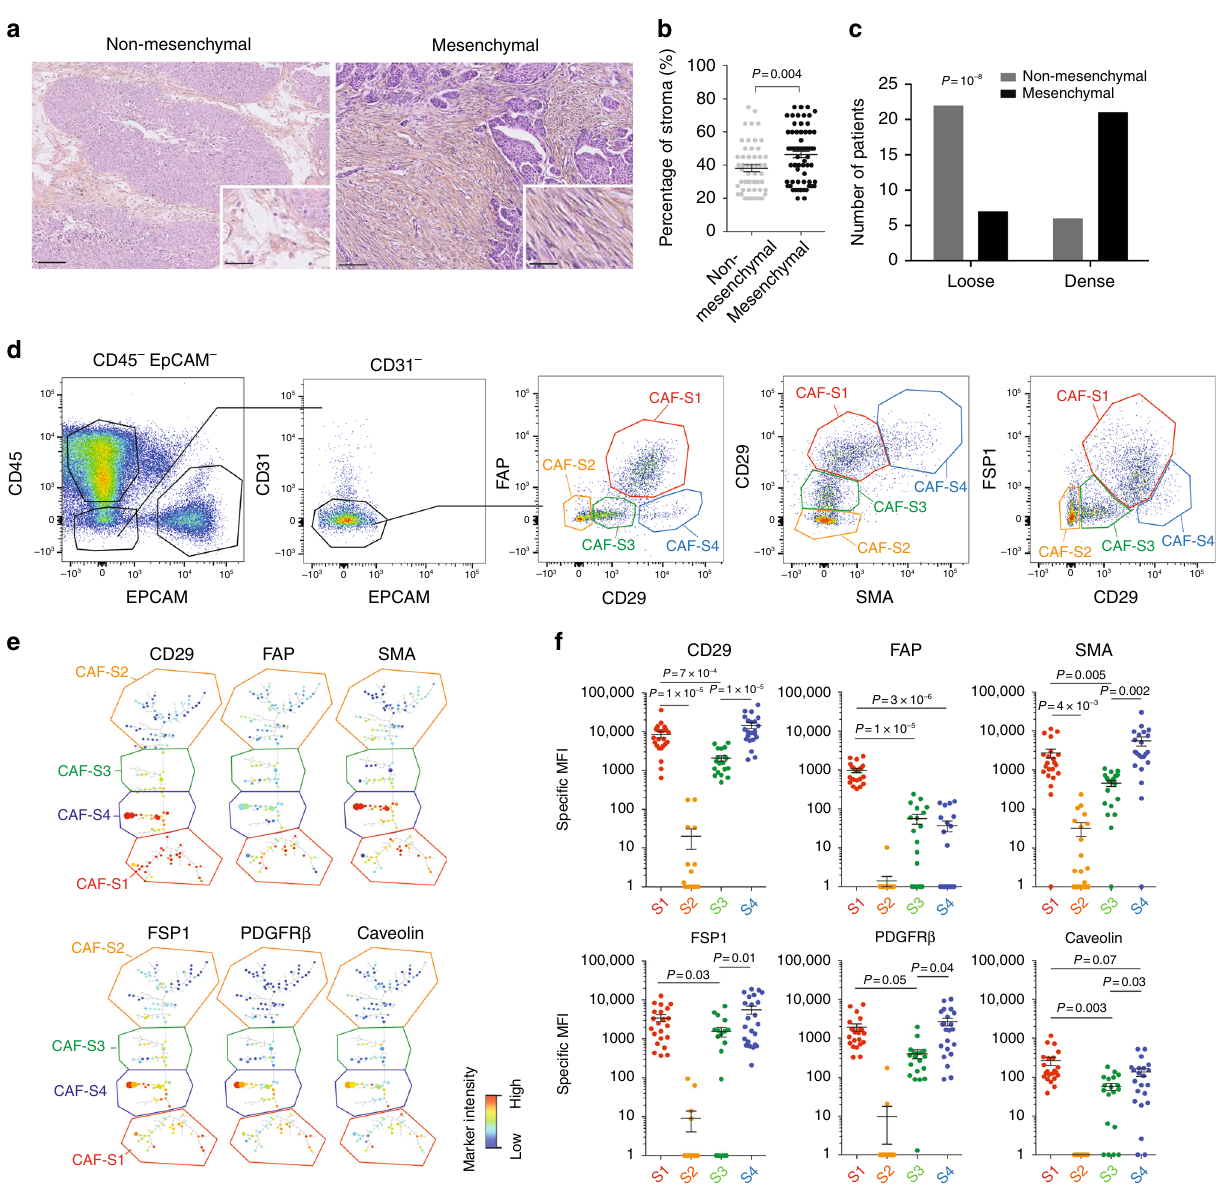
Fig. 1 Identi fi cation of four CAF subsets in HGSOC. a Representative view of HES staining of non-mesenchymal and mesenchymal HGSOC sections (Institut Curie cohort). Scale bar, 100 μ m (low magni fi cation) and 40 μ m (inset). b Scatter plot showing the percentage of stroma in HGSOC. N = 107. Data are shown as mean ± SEM. P values are from Mann-Whitney test. c Bar plot showing association of mesenchymal HGSOC with stromal features, de fi ned by pathologists as loose (low stromal cellularity) or dense (high stromal cellularity). N = 56. P value is from Fisher ’ s Exact Test. d Gating strategy to identify CAF subsets in HGSOC by FACS. Results from a representative HGSOC patient are shown. Cells isolated from freshly dissociated human HGSOC were fi rst gated on DAPI − , EPCAM − , CD45 − , CD31 − cells, for excluding dead cells (DAPI + ), epithelial cells (EPCAM + ), hematopoietic cells (CD45 + ), and endothelial cells (CD31 + ). Selected cells were next examined using six fi broblast markers. Representative fl ow cytometry plots show gating strategies based on FAP, CD29, SMA, and FSP1 that allow the identi fi cation of four sub-populations of fi broblasts in HGSOC: CAF-S1 are CD29 Med FAP High SMA High FSP1 High , CAF-S4 are CD29 High FAP Low SMA High FSP1 Med , CAF-S3 are CD29 Low FAP Low SMA Low FSP1 Med/High and CAF-S2 are CD29 Low FAP Low SMA Low FSP1 Low . e CytoSpade trees annotated with each marker expression in HGSOC analyzed by FACS. Colors show staining intensity for each marker. Size of the nodes is proportional to the number of cells showing similar staining for the markers analyzed. f Scatter plots showing speci fi c mean fl uorescent intensity (MFI) detected for each marker in each CAF sub-population. Each dot represents the speci fi c median of fl uorescent intensity of the cellular population by patient. N = 22. Data are shown as mean ± SEM. P values are from Student ’ s t- compartment. We applied a decision tree algorithm (Fig. 2b) to determine the global CAF subset enrichment per tumor. In brief, this decision tree was based on marker intensity thresholds, fi rst Supplementary Table 1 for list of antibody references and de fi ned according to FACS data (intensities of each CAF marker Supplementary Fig. 1a for isotype controls). We evaluated in each CAF subset) from fresh HGSOC samples and next histological scores (H score) for each marker in the stromal transposed to IHC values (see Methods, #Development of a